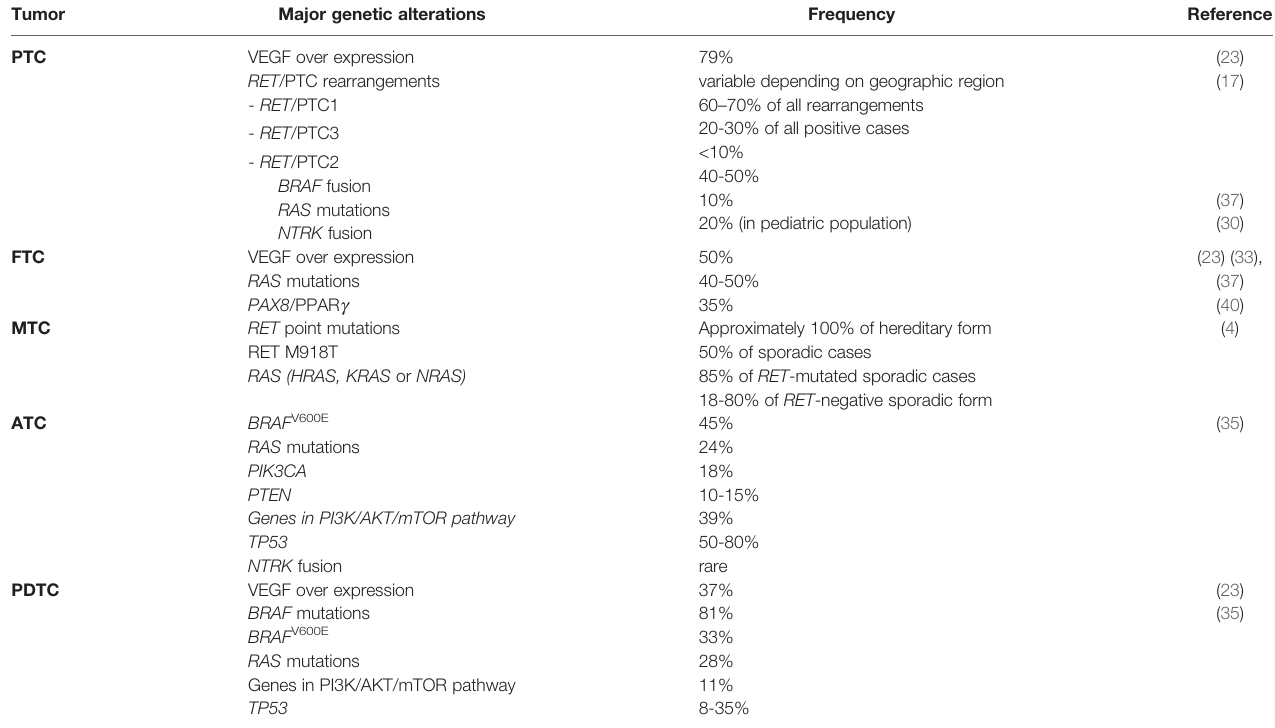
TABLE 1 | Most frequent molecular alterations in various thyroid